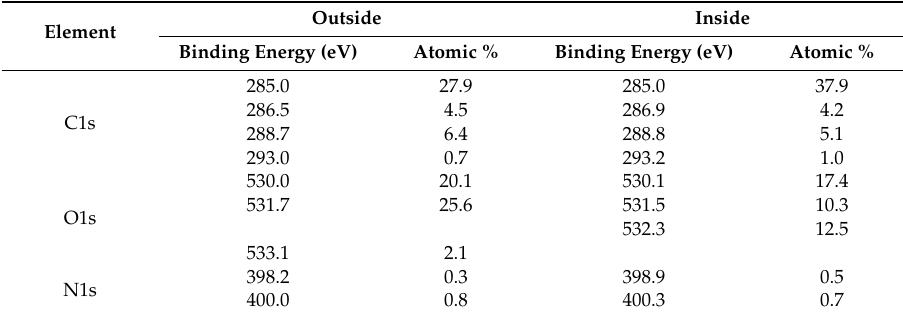
Table 4. XPS binding energies and atomic percentages inside and outside the wear track after lubrication with neat IL thick film.